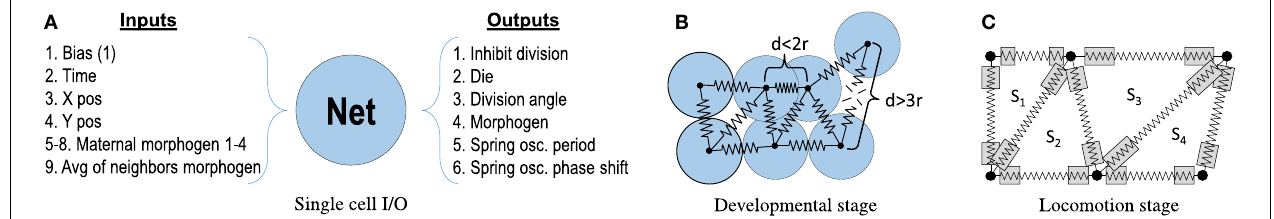
FIGURE 2 | Basics assumptions of the developmental and soft-body system . (A) Each cell is controlled by a copy of the regulatory network encoded in the genome. The output configuration shown was used in the basic, oscillator-driven actuation experiments (see Section 2.6.1). In the GRN experiments (Section 2.6.1), outputs 5 and 6 were replaced with a single output that actively determines spring deviation. (B) Physical interactions between cells during developmental stage. Cells are represented as point masses connected with springs of a fixed resting length equal to 2 cell radii, simulating adhesive force ( d > 2 r ) or repulsion ( d < 2 r ). Springs are removed if cells find themselves at a distance larger than 3 radii. (C) Soft-body representation of an animat during the locomotion stage. Cells are connected by springs of different rest lengths, determined by cell distances at the end of developmental stage. In analogous way, each triangular region has an equilibrium area S i associated with it. Compression of a region results in an outward forces acting on the nodes, expansion results in inward forces. To produce animat movement, each cell synchronously shortens or expands the resting lengths of all the springs attached to it, within a fixed range [gray boxes, see equations (1) and